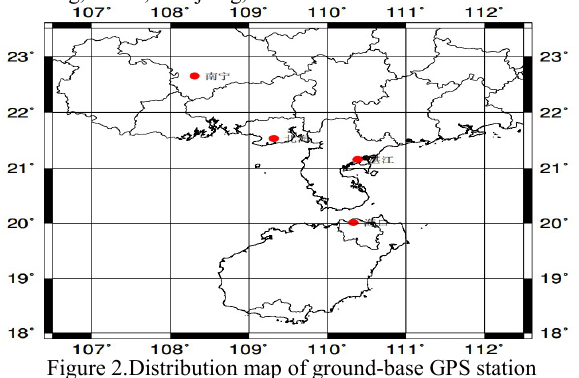
Figure 2.Distribution map of ground-base GPS station 2.4.2